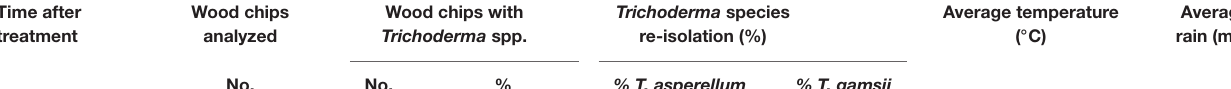
Trichoderma species re-isolation (%)